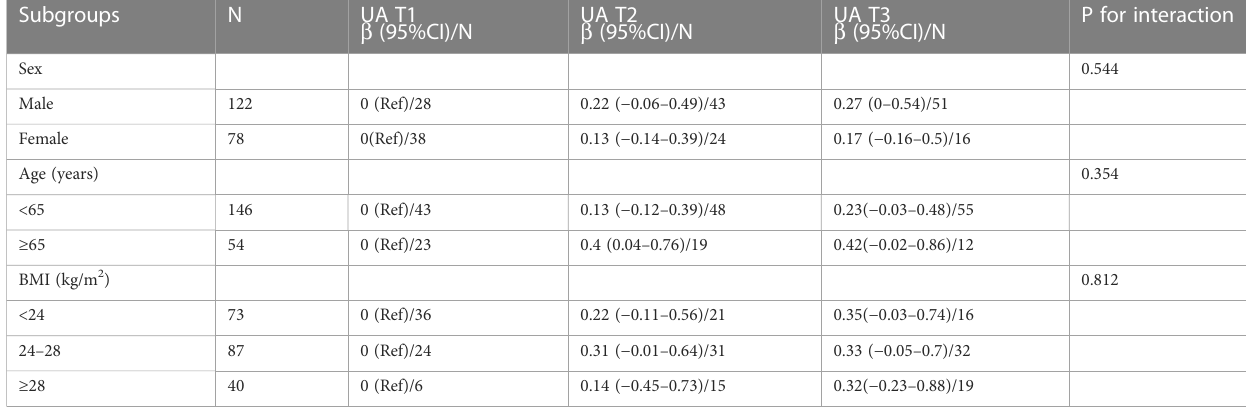
TABLE 4 Subgroup analysis between serum uric acid and phase angle.